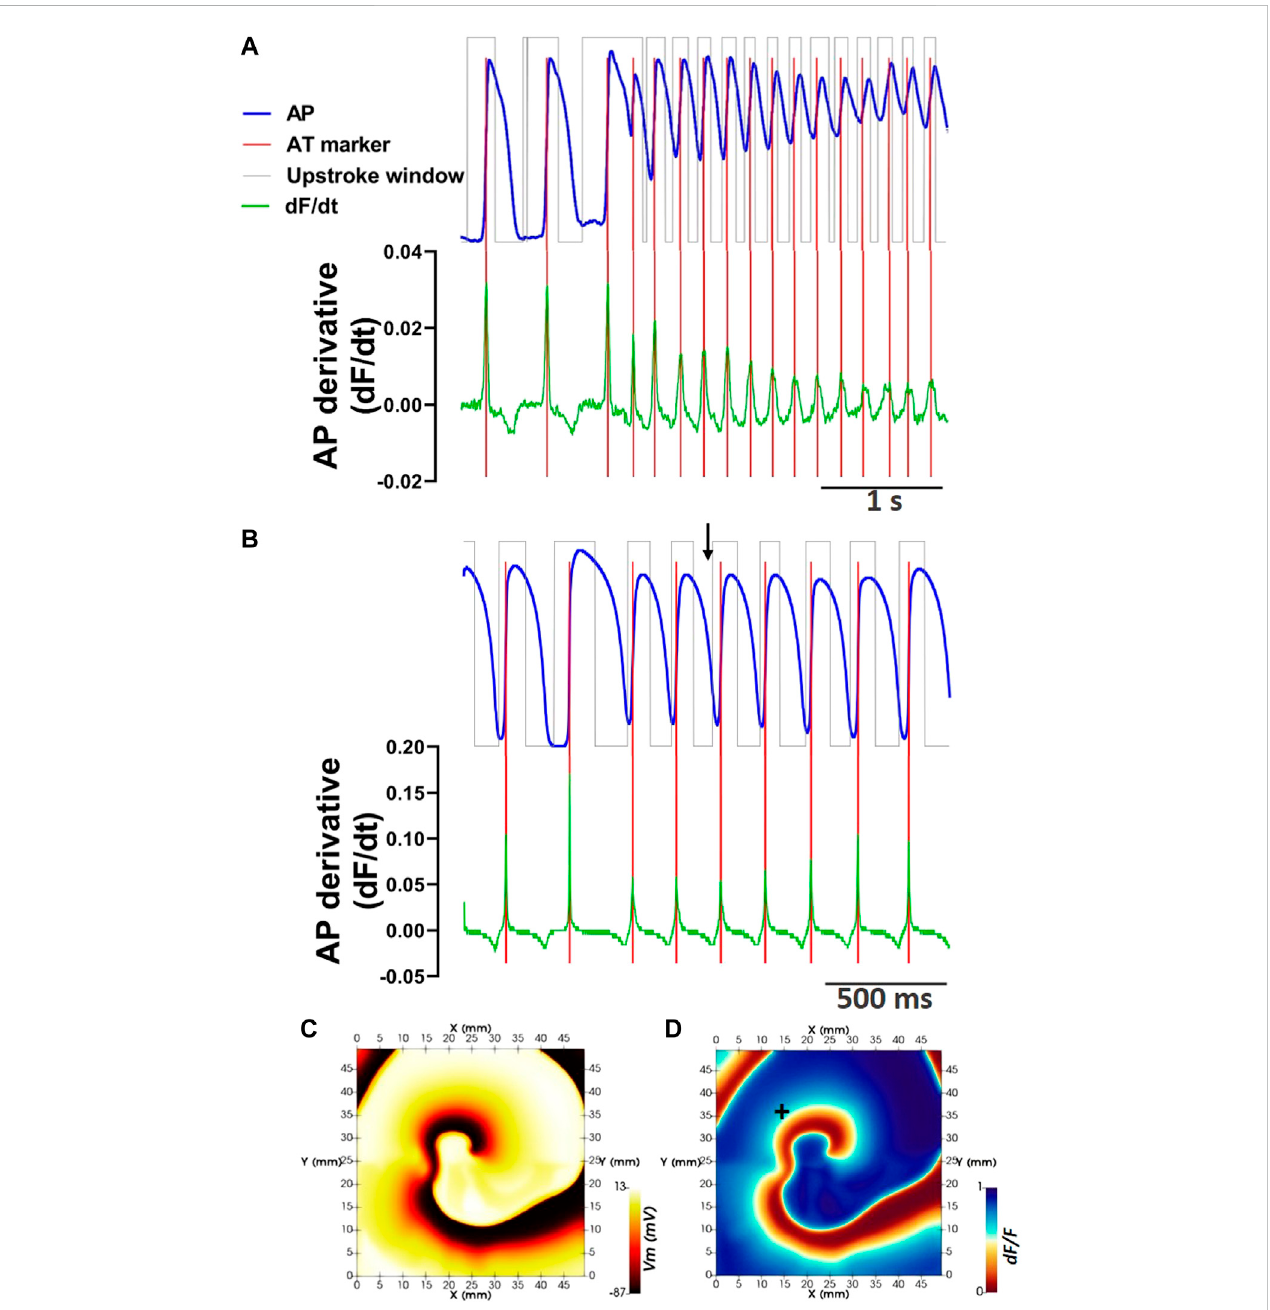
FIGURE 3 De fi ning phase window-independent upstroke morphology and pAT using the signal derivative. (A) Extraction of the pre-processed optical action potential signal during reentry from pixel coordinate (20,10). Corresponding phase windows of pAT are superimposed. The derivative of the corresponding signal is shown. Pronounced derivative peaks falling within phase windows indicate pAT (red lines). (B) Similarly, an optical action potential signal and corresponding derivative extracted from an in silico model of reentry. (C) Membrane voltage ( Vm ) map extracted from the epicardial surface of the electrical in silico model at the time indicated by a black arrow in (B) . (D) Corresponding F/dF computed from the in silico model. In silico optical signal in B extracted from pixel indicated by +